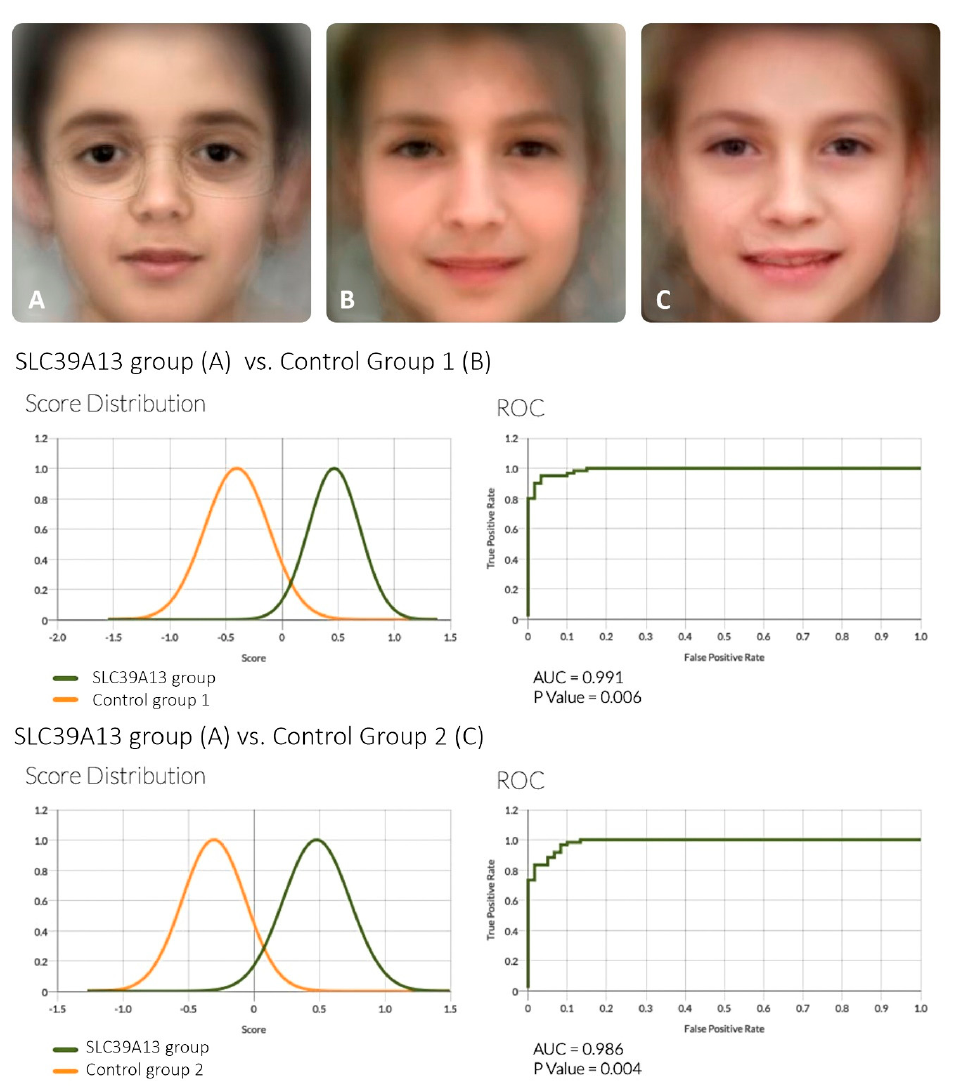
Figure 2. DeepGestalt technology analysis of facial features in SLC39A13 deficiency. The upper part shows the “averaged” artificial composite facial gestalt image of individuals with SLC39A13 deficiency (panel A ) vs. two matched control groups (panels B and C ). The lower part shows the result of the comparisons between A vs. B, and A vs. C.